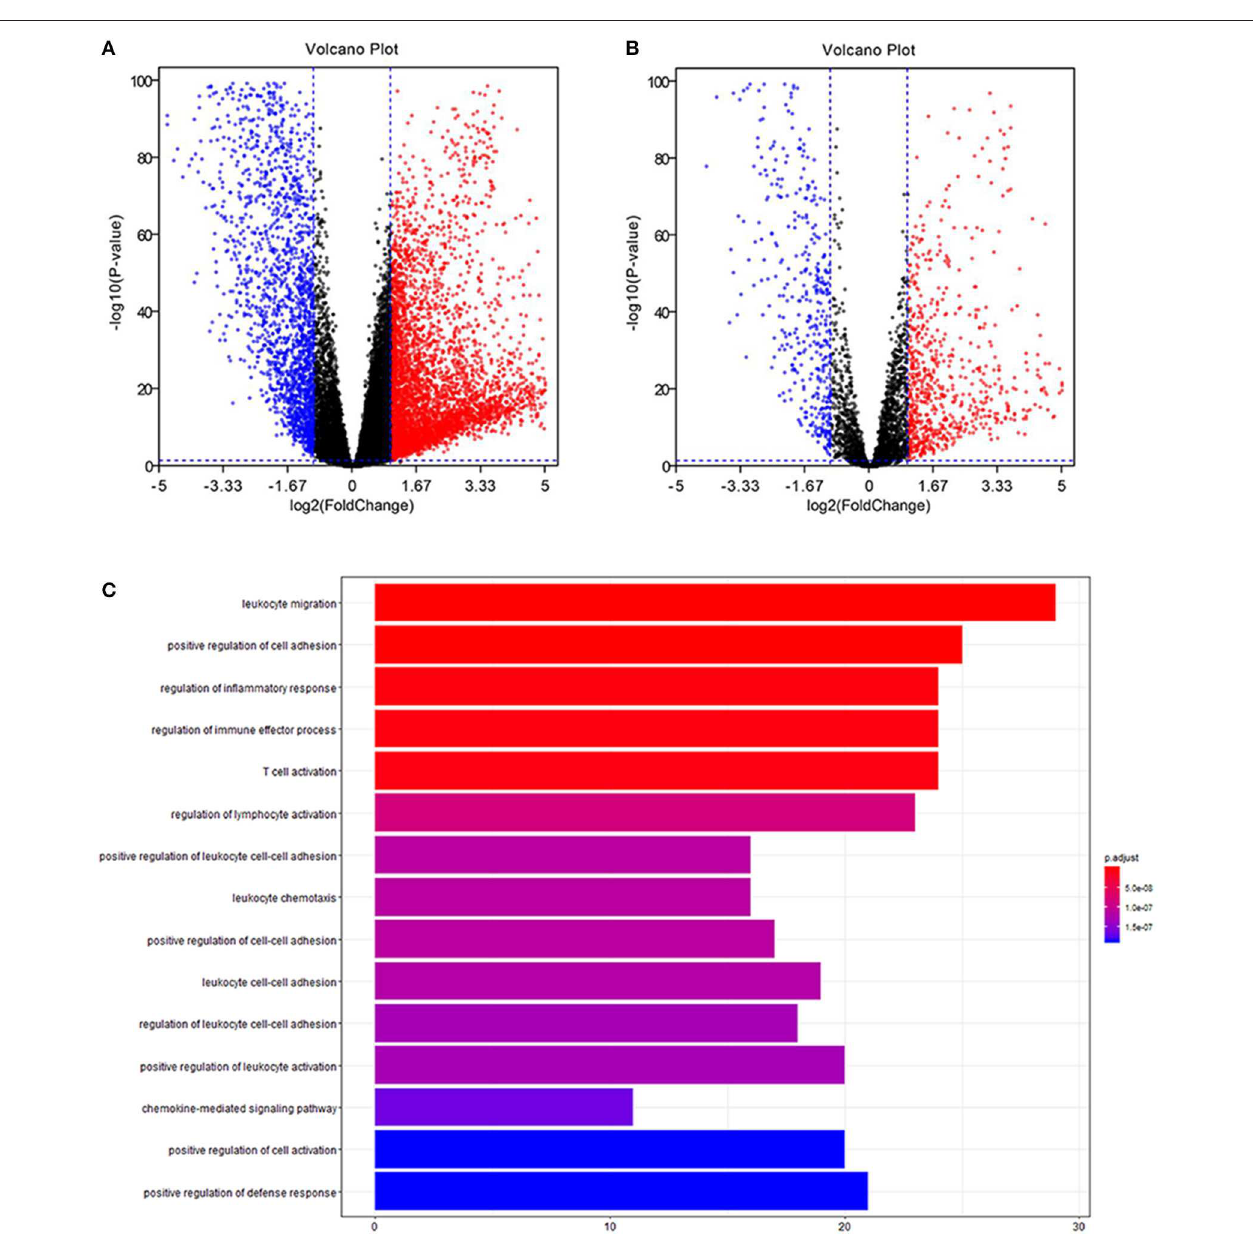
FIGURE 1 | Differentially expression and functional enrichment. (A) Volcano chart of differentially expressed genes. (B) Volcano chart of immune differentially expressed genes. (C) Barplot chart for functional enrichment analysis.